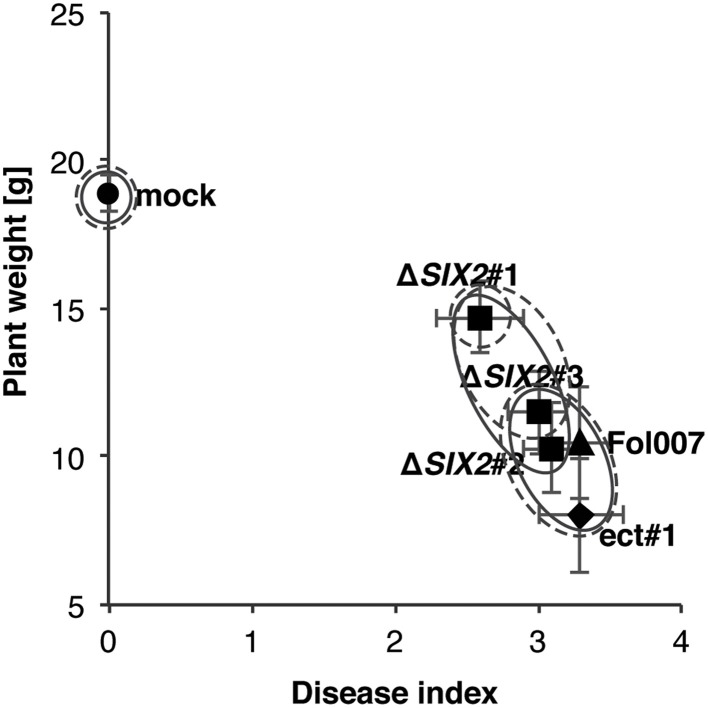
One SIX2 knockout is reduced in virulence. Susceptible tomato seedlings were inoculated with wild-type Fol (Fol007) or strains in which SIX2 was deleted (ΔSIX2#1-3). As controls mock-inoculated plants were used (mock) or one transformant (ect#1), in which the SIX2 deletion construct was integrated ectopically. Average plant weight of 15 plants was plotted against the average disease index of the same plants. In ΔSIX2#1 pathogenicity was impaired as shown by the increased plant weight as compared to infection with Fol007 and the ectopic transformant. Error bars represent the standard error. Clustering is based on an ANOVA (Fisher PLSD significant at 95%) using either the disease index (solid line) or plant weight (dashed line).